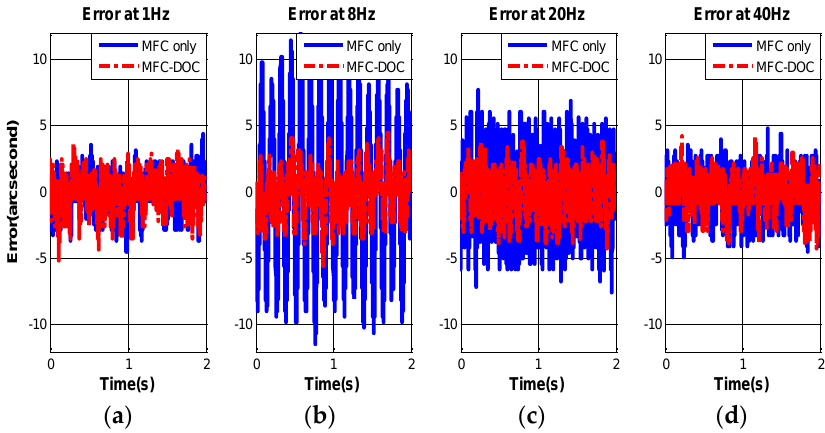
Figure 10. ( a ) Line-of-sight (LOS) error at 1 Hz disturbance; ( b ) LOS error at 8 Hz disturbance; ( c ) LOS error at 20 Hz disturbance; and ( d ) LOS error at 40 Hz disturbance.